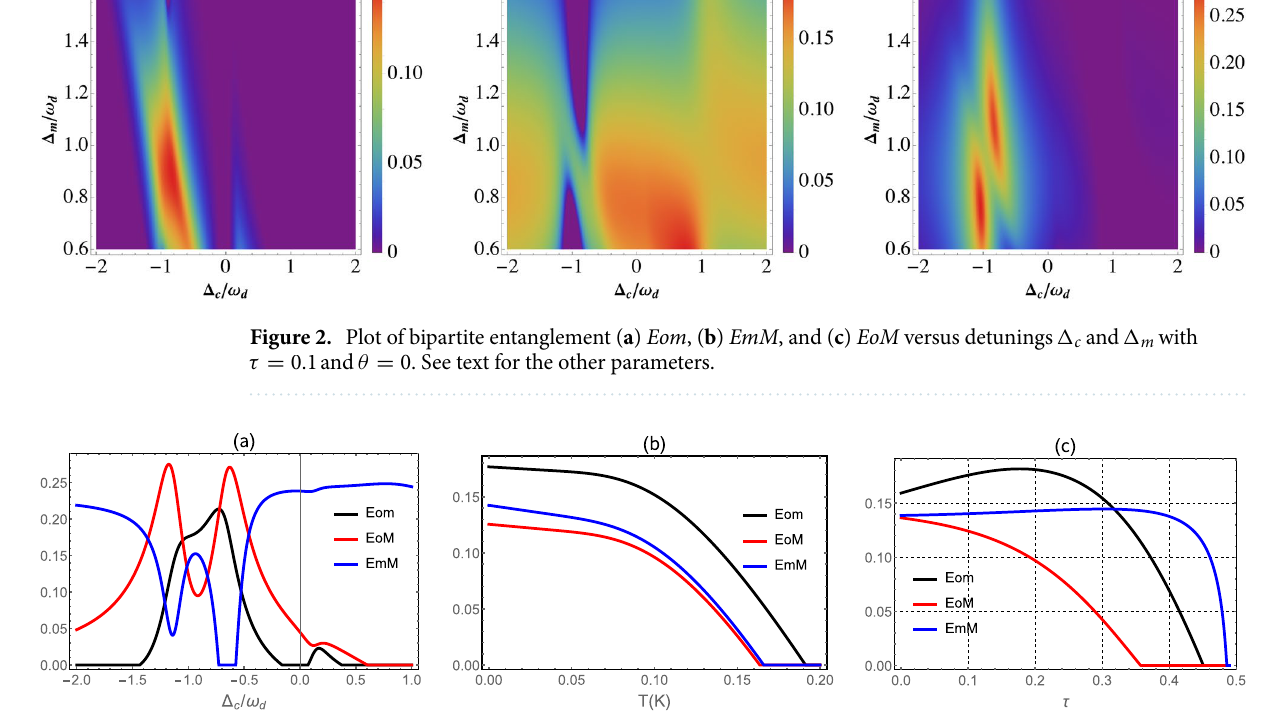
Figure 3. ( a ) Plot of Eom , EoM and EmM as a function of � c /ω d , ( b ) temperature and ( c ) reflectivity τ . We take 4.8 MHz and � m 0.9 ω d . The other parameters are same as in Fig. 2; τ G md / 2 π = = 10 mK) ( a – c ). See text for the other 20.34 ( T n d = =